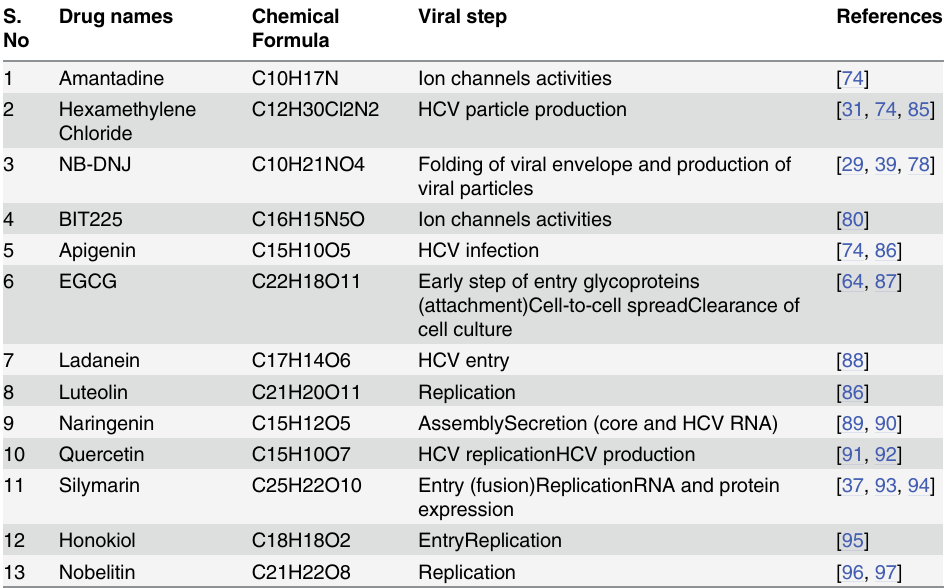
Table 2. Different types of active ligands taken into in silico study, with their chemical formula and their predicted function in disrupting different stages of viral cycles. S.